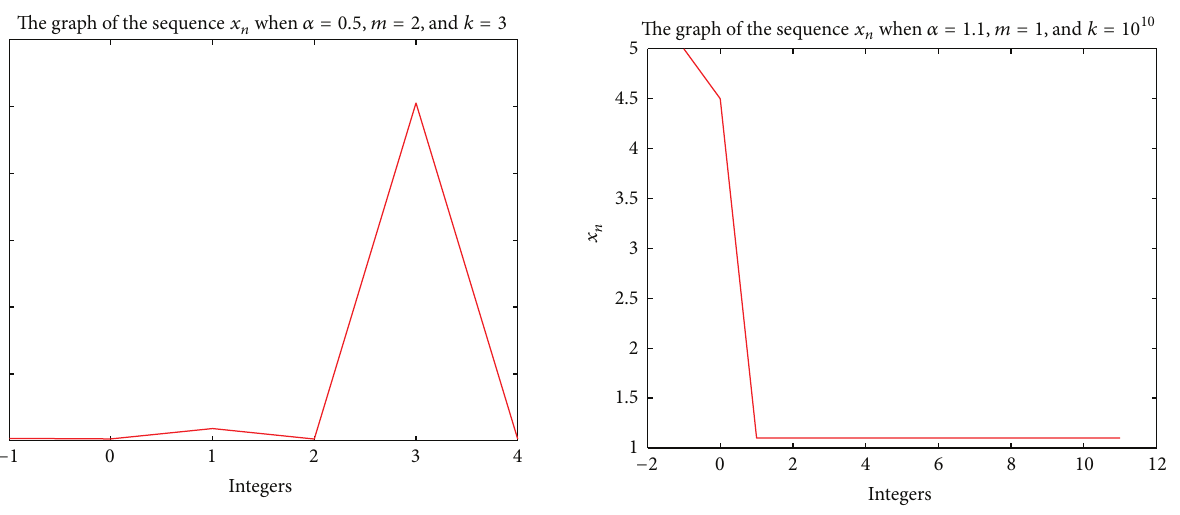
Figure 3: When 𝑚 > 1 there exists an unbounded positive solution.